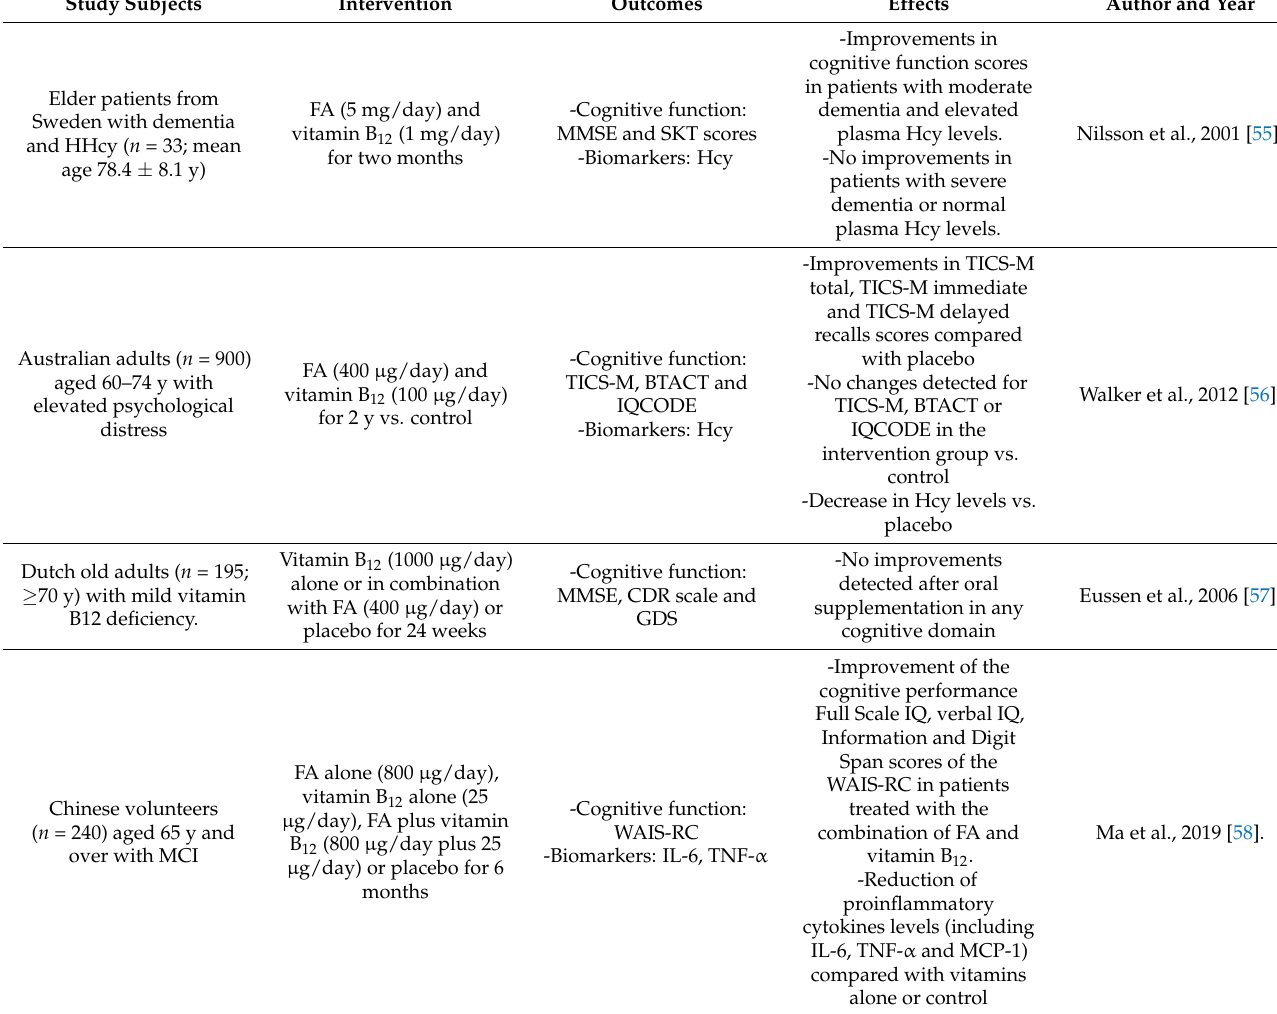
Table 2. Summary of the interventions based on folic acid and vitamin B 12